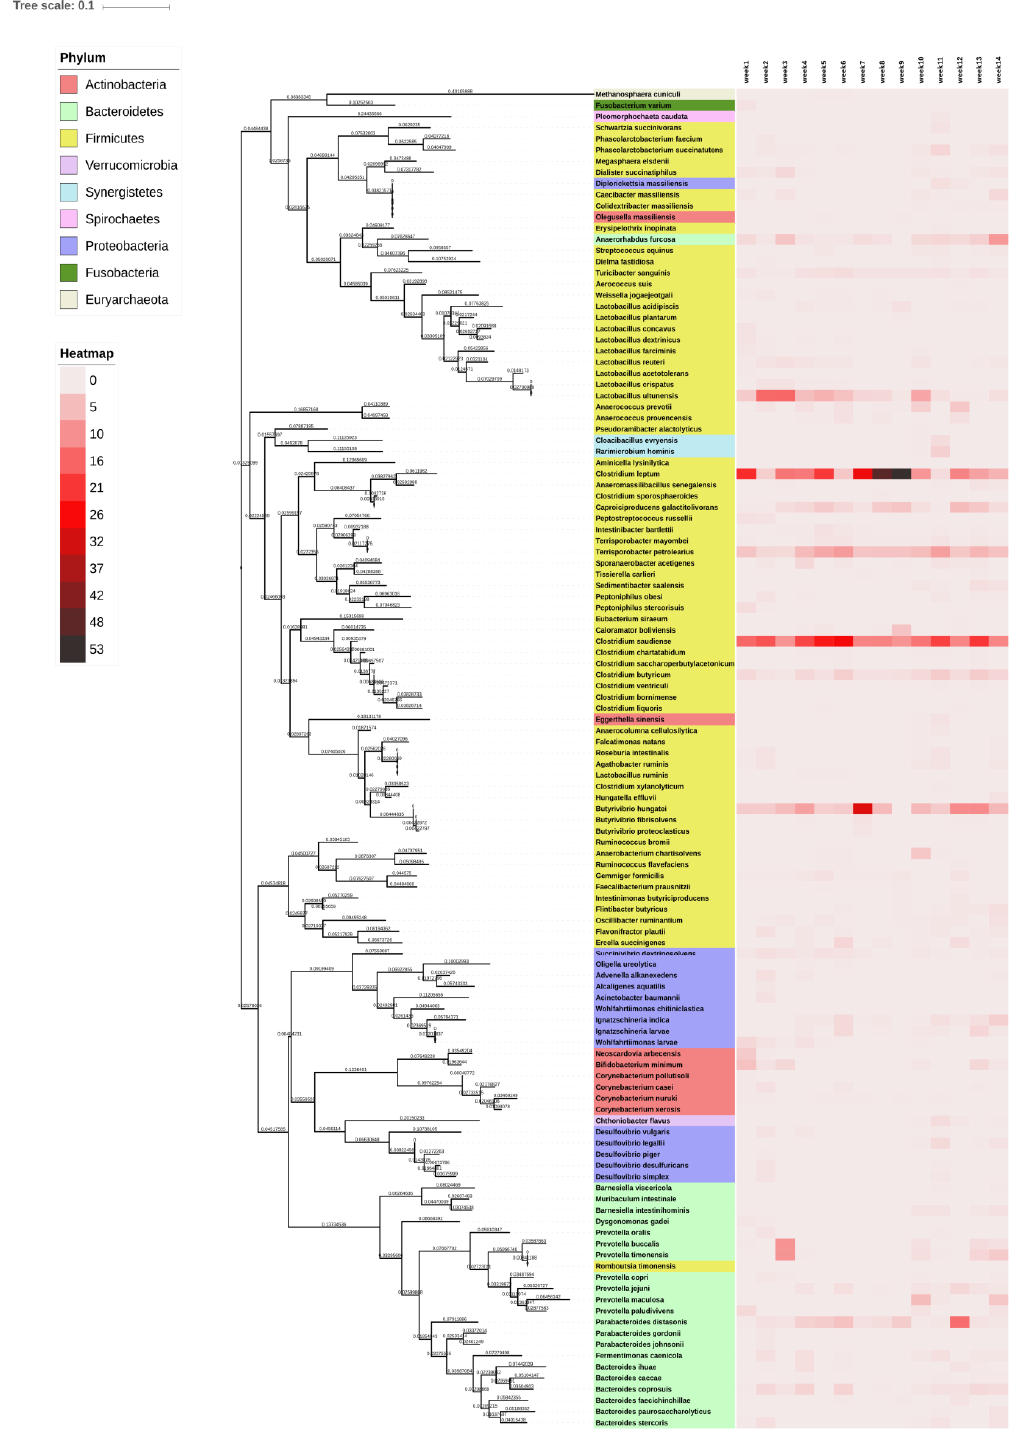
Figure 5. Phylum and species level phylogenetic tree of the 16S rRNA genes through maximum likelihood. Weekly sample indicated as column wise. likelihood. Weekly sample indicated as column